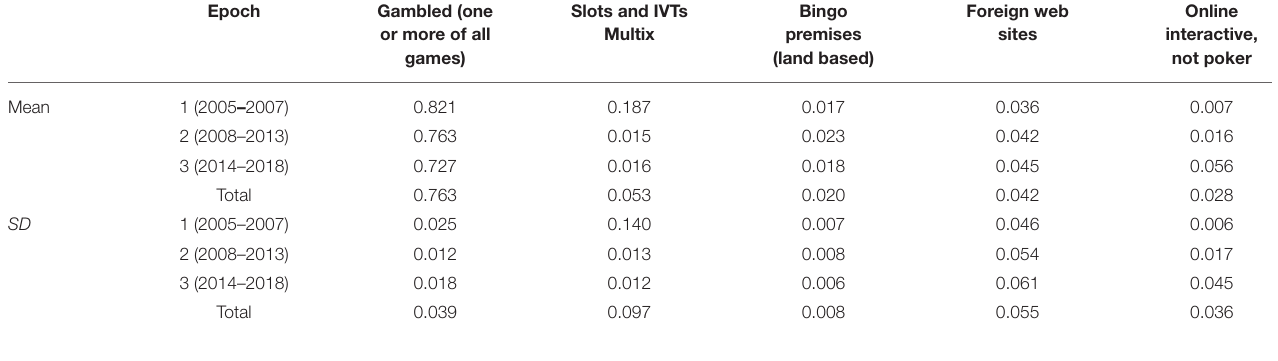
TABLE 2 | Predicted probabilities (0–1), mean and standard deviation ( SD ) of participation in gambling per time epoch ( N = 28,251, n = 6,243–12,008). Epoch Gambled (one Slots and IVTs Bingo or more of all Multix premises games) (land based)